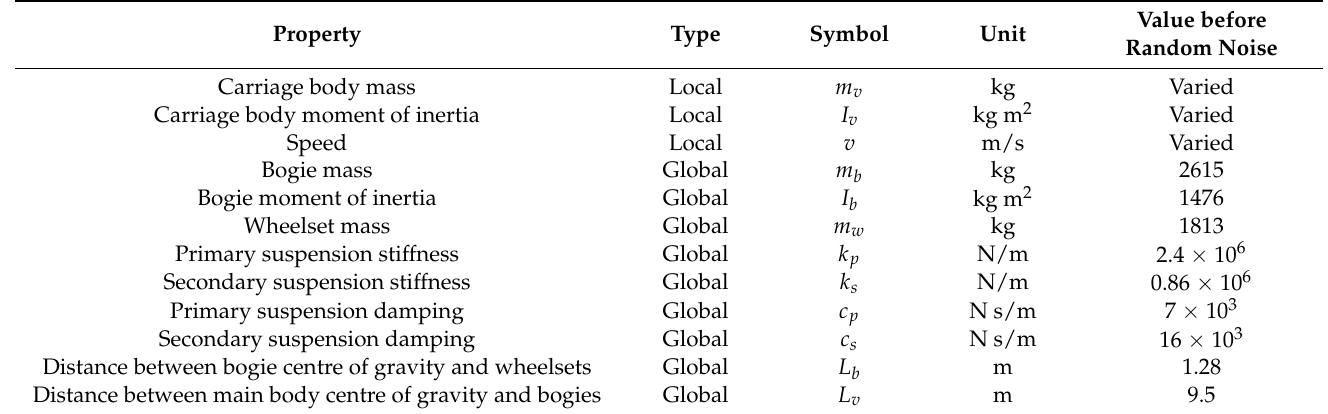
Table 4. Carriage vehicle properties in the blind